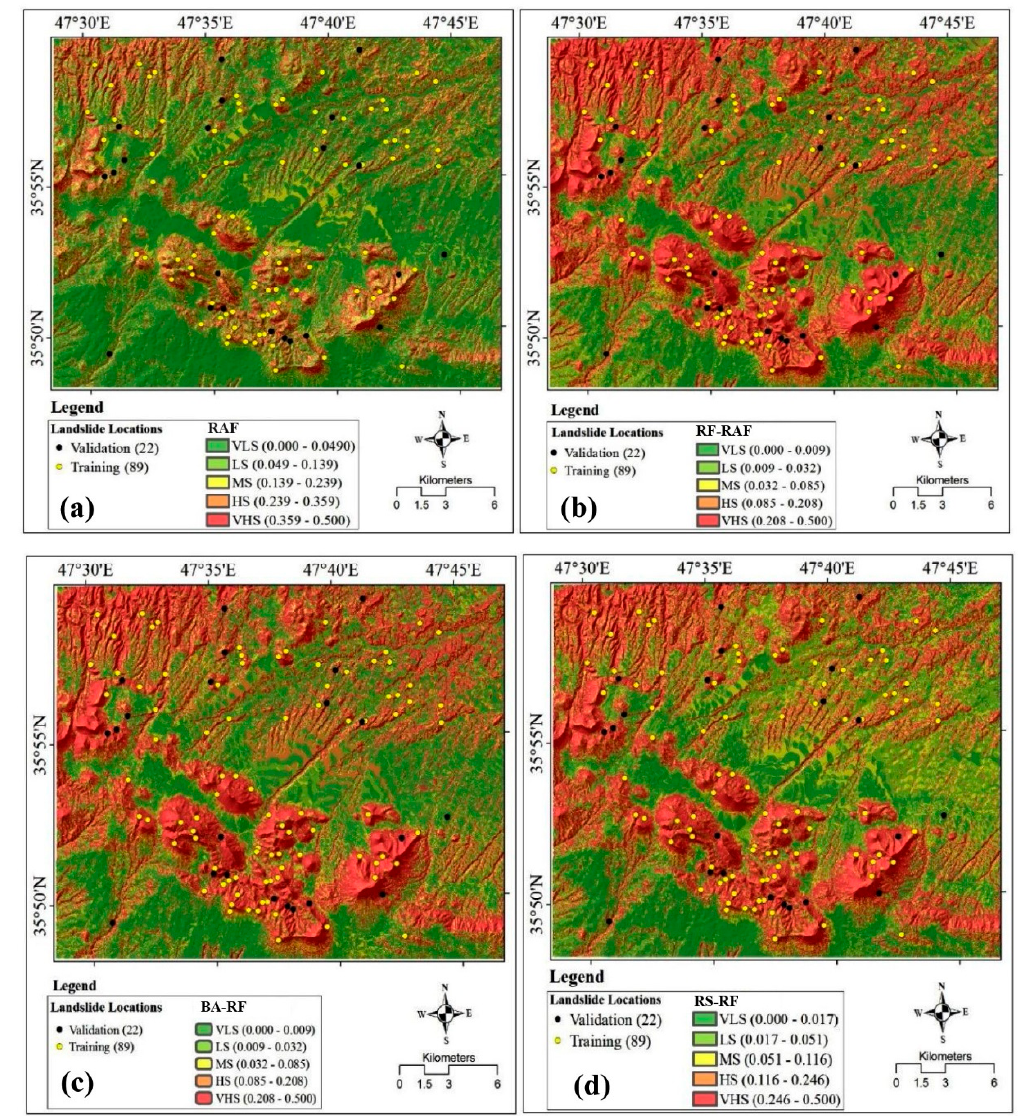
Figure 6. Shallow landslide susceptibility maps produced using the ( a ) RAF model, ( b ) RF-RAF model, ( c ) BA-RF model, and ( d ) RS-RF model.